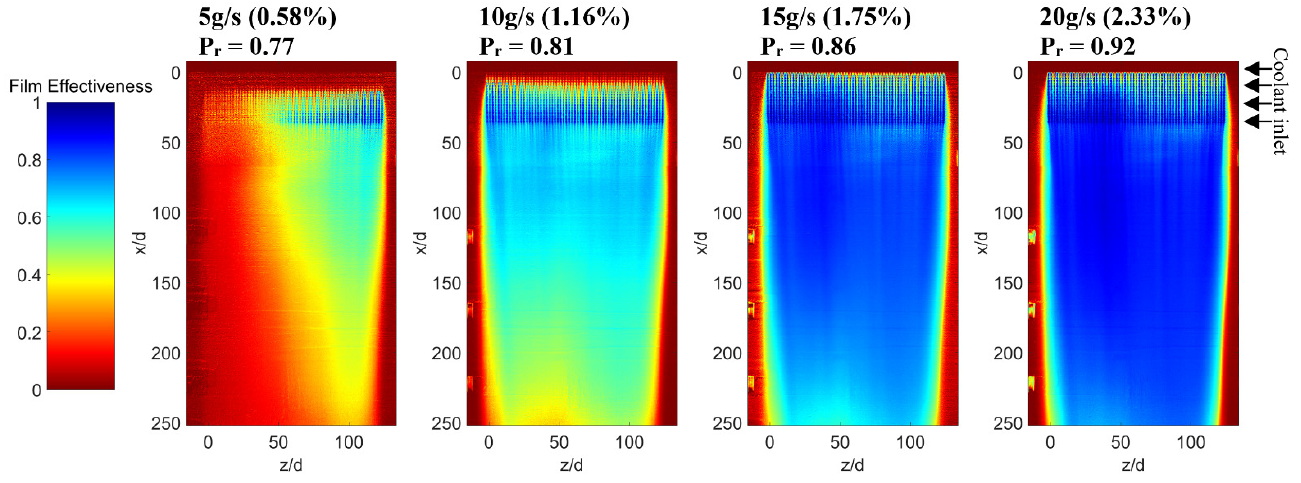
Figure 8. Film effectiveness of Panel 6 at different coolant mass flow rates (mass